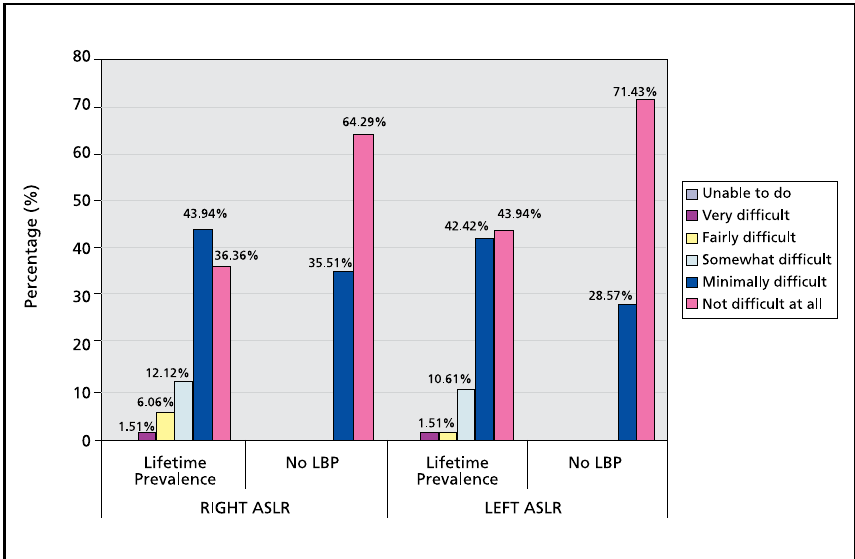
Figure 3: subjects perception of